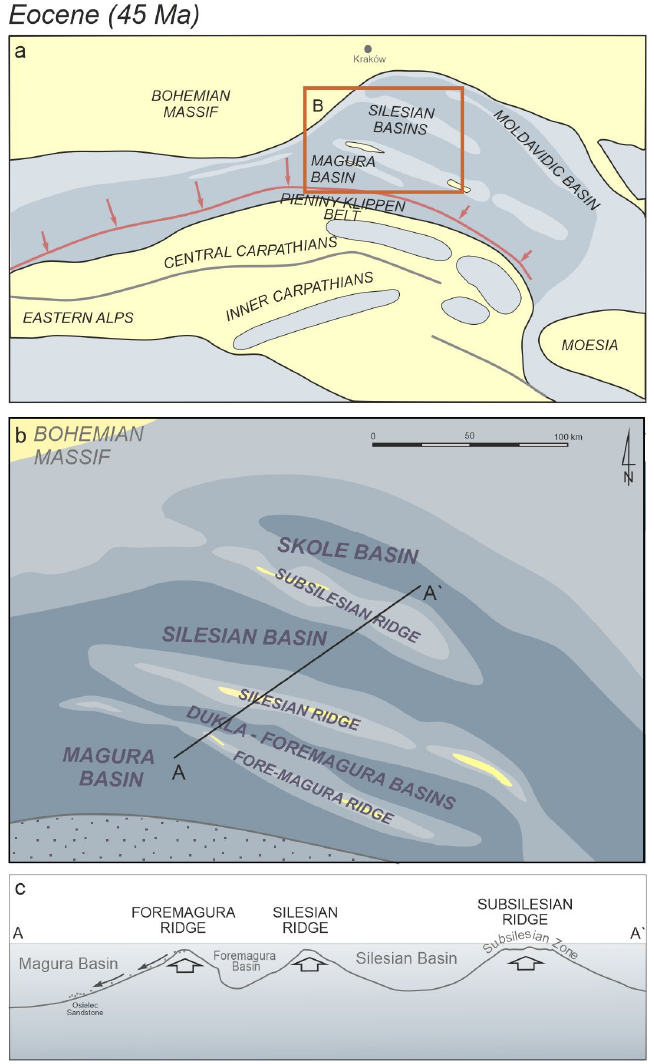
Figure 8. ( a , b ) Paleogeographic reconstruction of the circum-Carpathians area ( c ) with a palinspastic cross-section in the Early Paleogene [1].